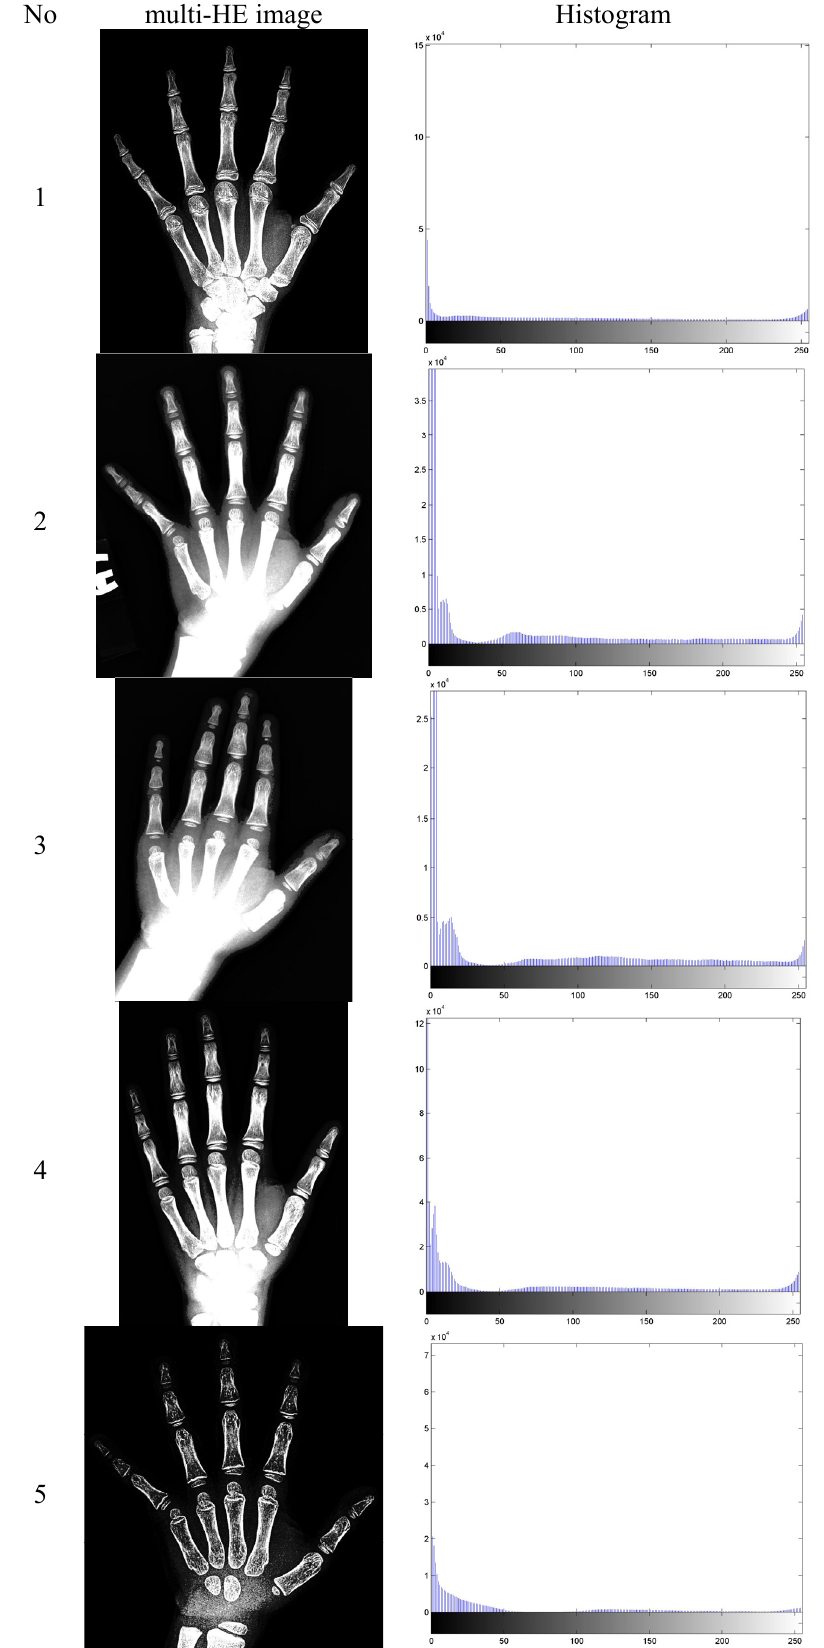
Figure 4. The output images and their histograms